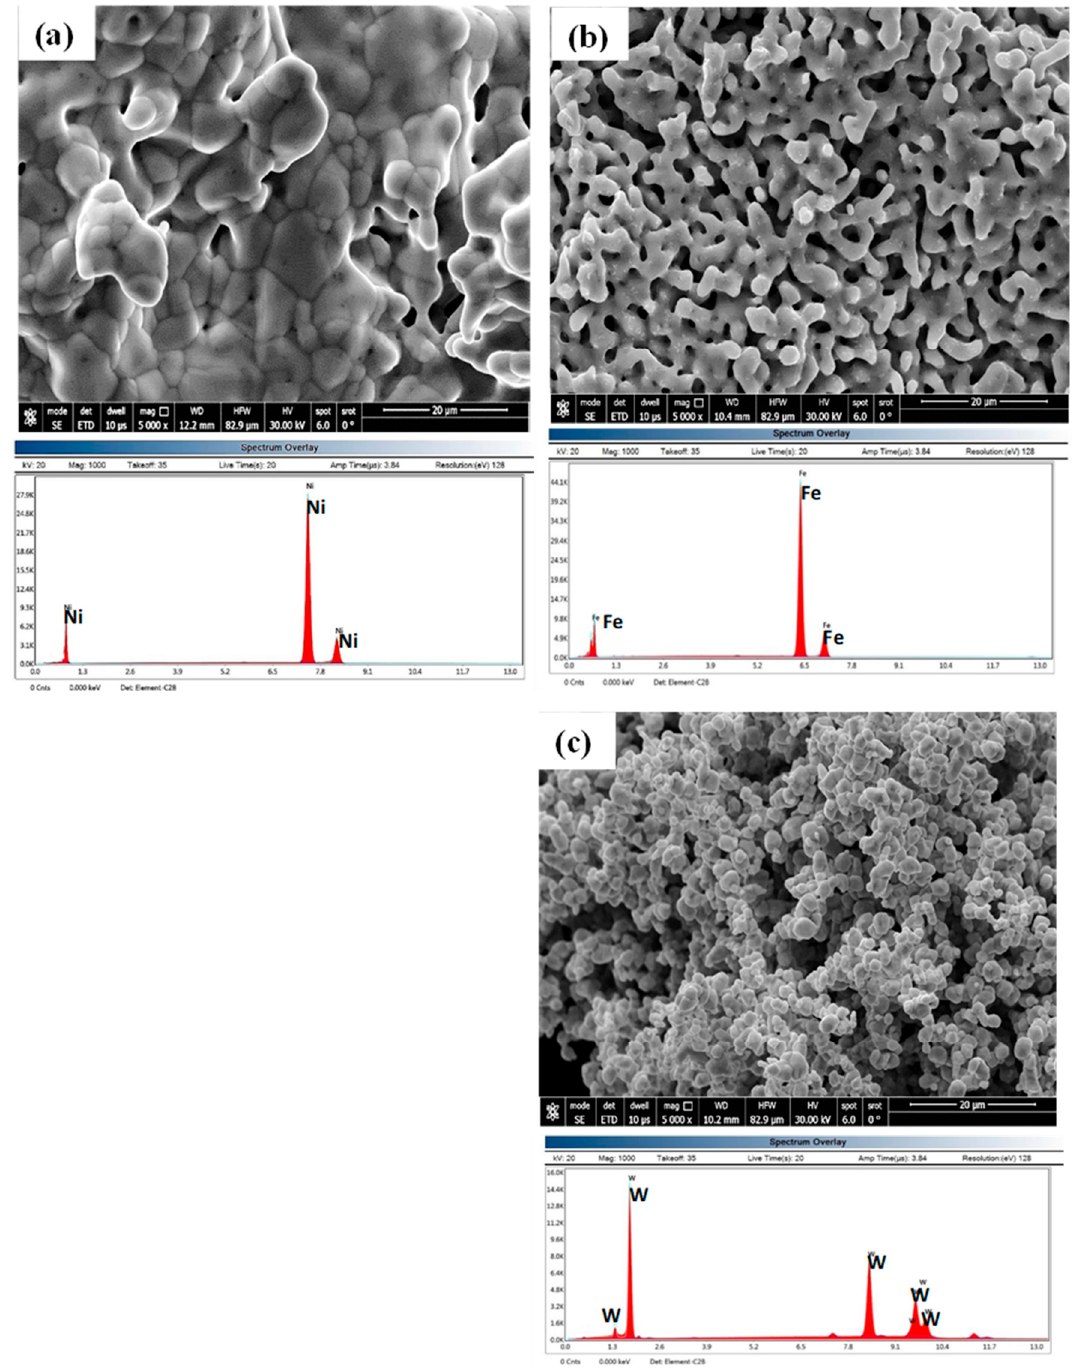
Figure 8. SEM-EDAX images of nanosized metal oxides reduced with H 2 at 1000 °C: ( a ) NiO; ( b ) Fe 2 O 3 ; ( c ) WO 3 .